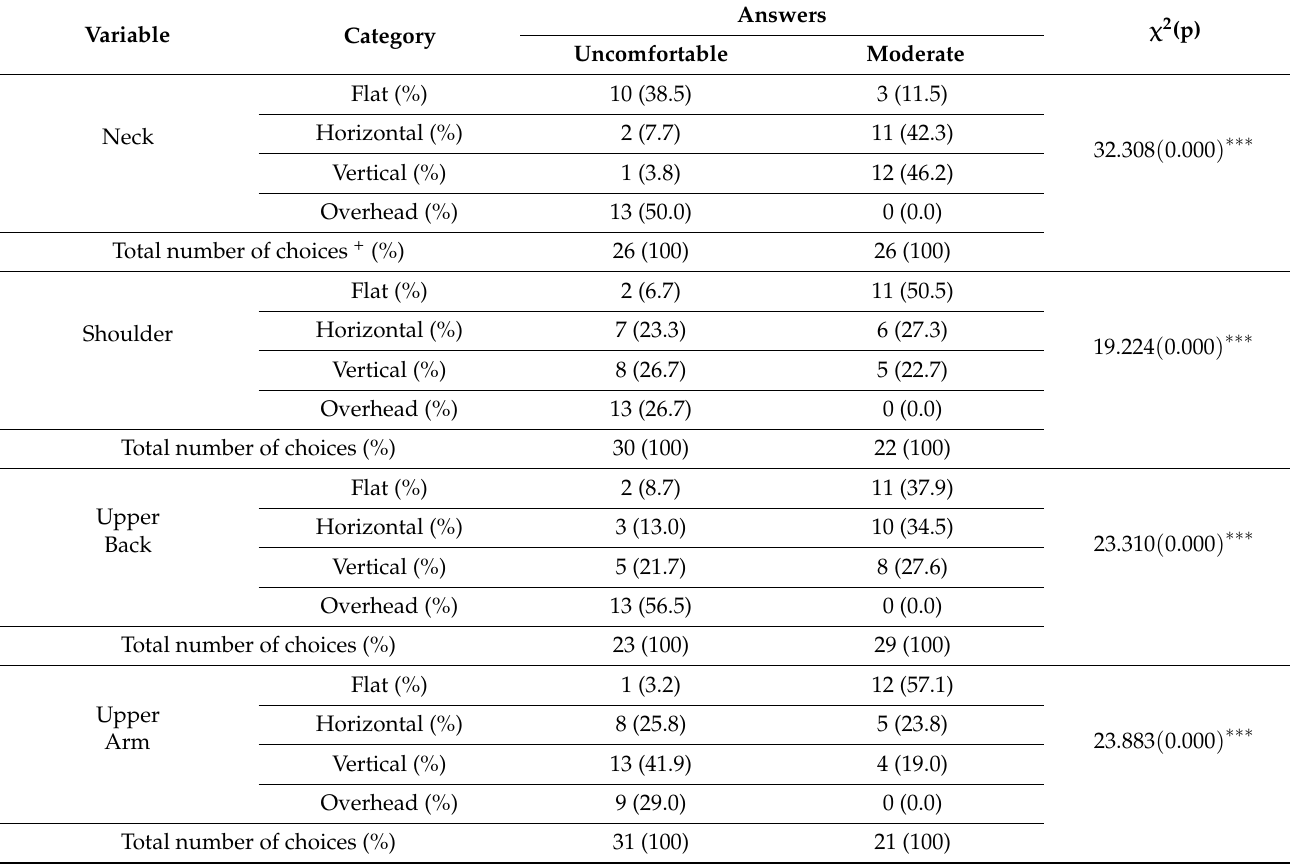
Table 2. Results of chi-square test and Fisher’s exact test for selection of influencing